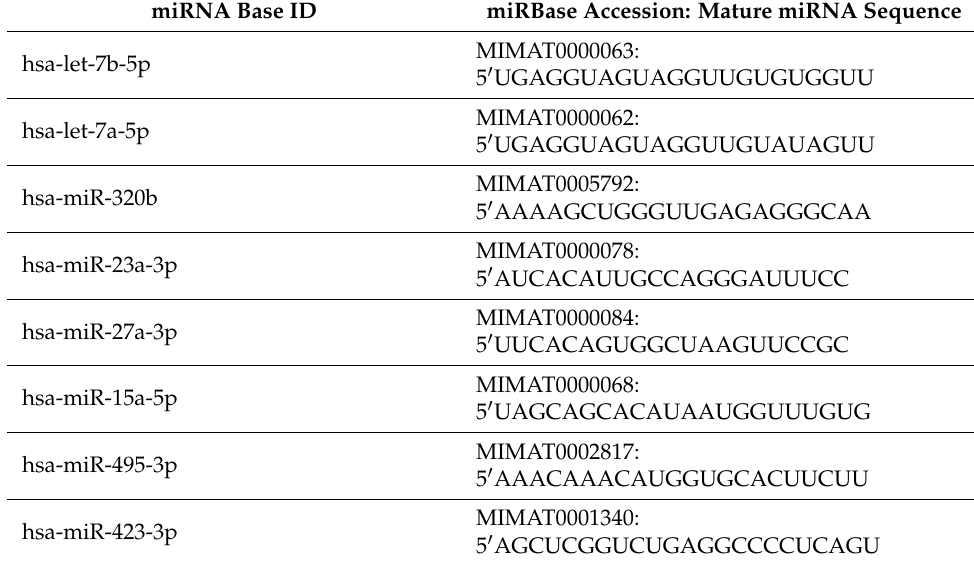
Table 1. miRNA accession